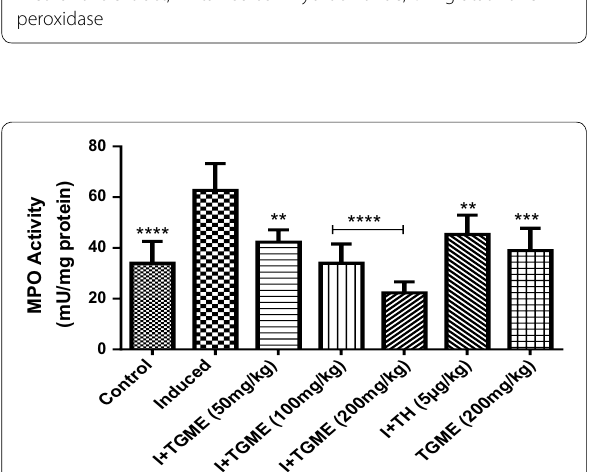
Fig. 11 Effect of aqueous methanolic leaf extract of Triclisia gilletii on concentration of FRAP in the kidney of animals administered ethane-1,2-diol. Data are expressed as mean * < 0.05, *** p < 0.001, and **** p < 0.0001; *denotes that data were compared with ethane-1,2-diol; TGME Triclisia gilletii aqueous methanolic extract, TH tamsulosin hydrochloride, FRAP ferric reducing antioxidant power